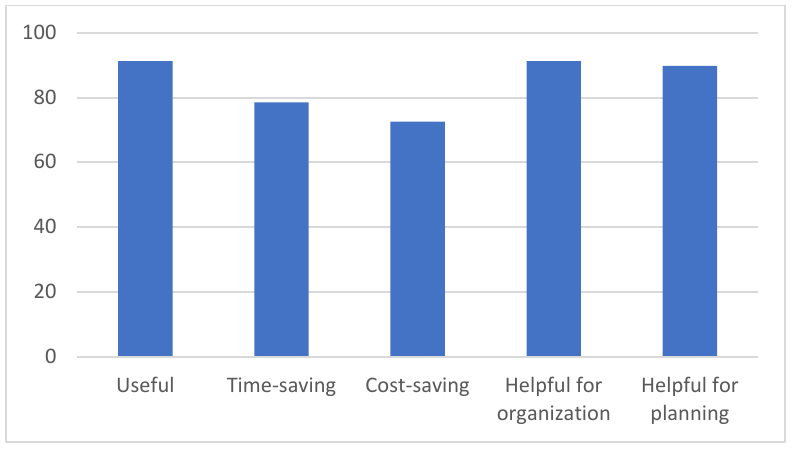
Figure 1. Citrus growers’ opinion on mobile devices.